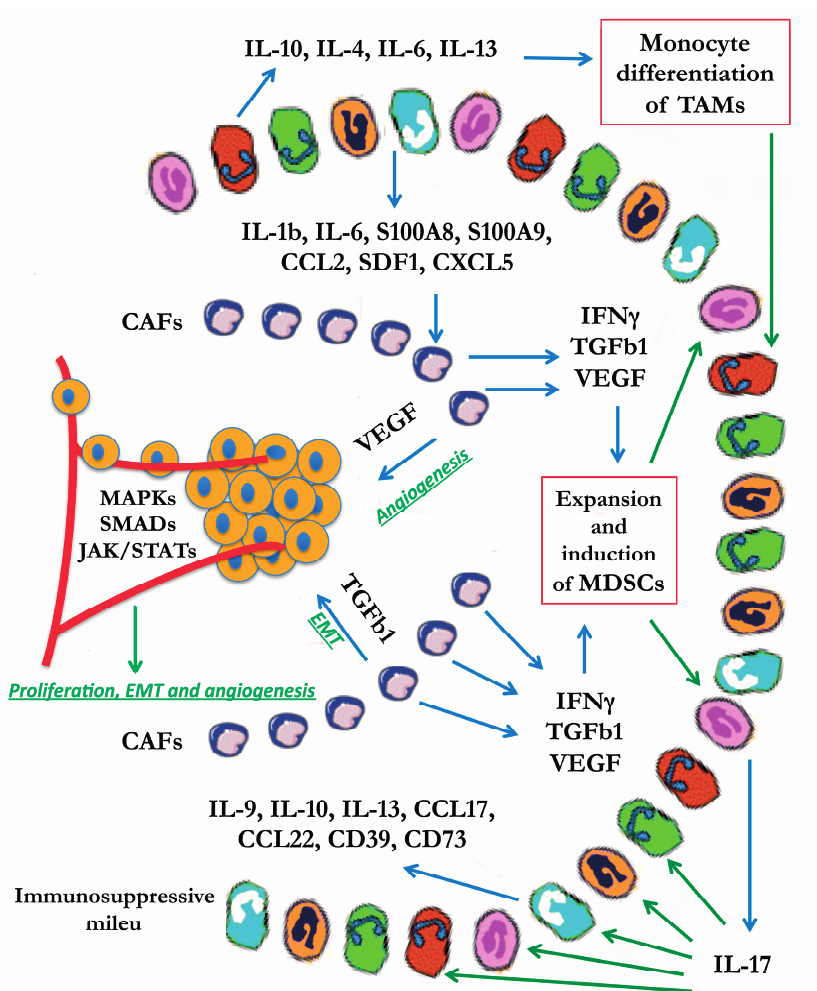
Figure 2. Inflammatory signaling in the tumor